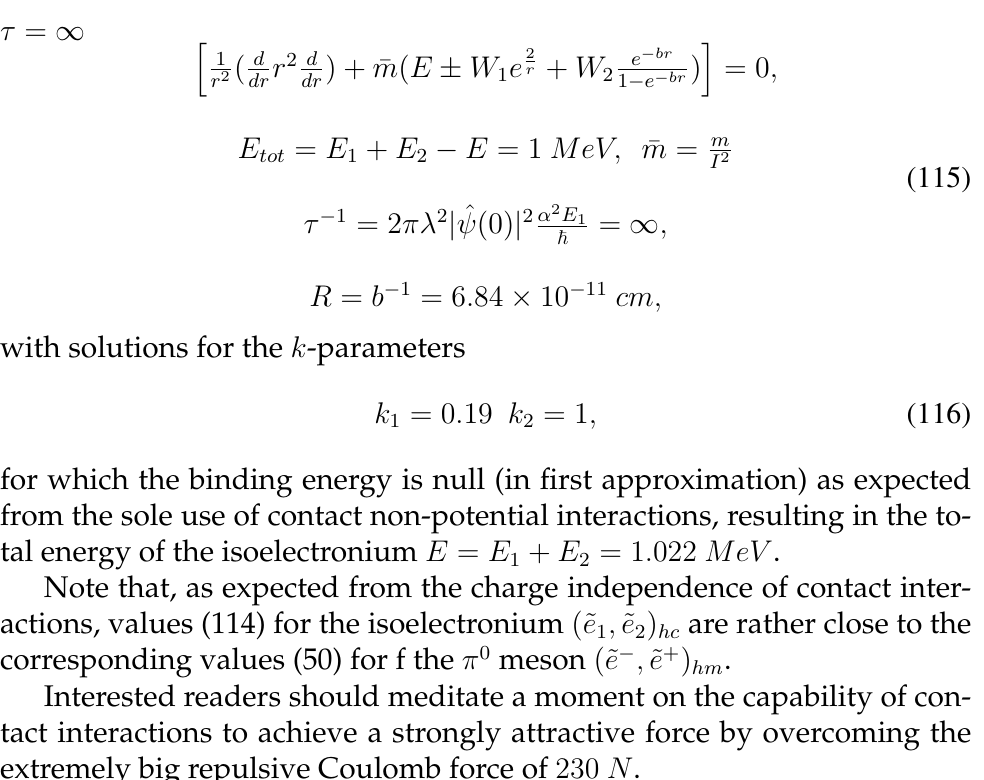
Figure 21: An illustration of the isochemical model of the hydrogen molecule achieved by R. M. Santilli and D. D. Shillady [52] with the following main features: 1) Valence elec- tron pairs are bonded into isoelectronia according to the principles of hadronic chemistry; 2) Due to their strong internal forces, isoelectronia are forced to have oo orbits around corresponding nuclei resulting in opposite angular momenta that represent the diamag- netic character of the hydrogen and other molecules; 3) The conventional four-body equa- tions for the hydrogen molecule are reduced to a restricted three-body form admitting a full analytic